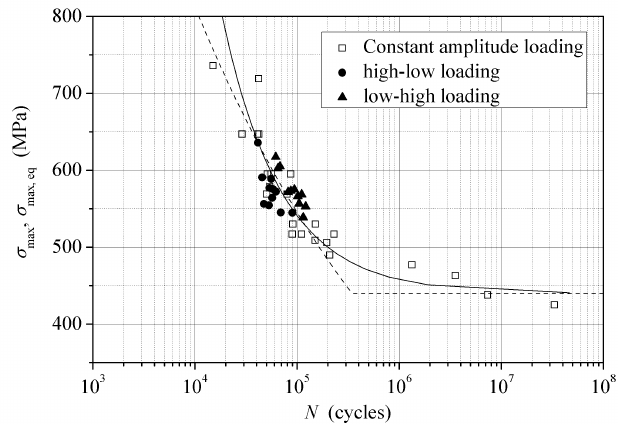
Figure 5. Comparison of fatigue lives under CAV and one-way two-level loading conditions.